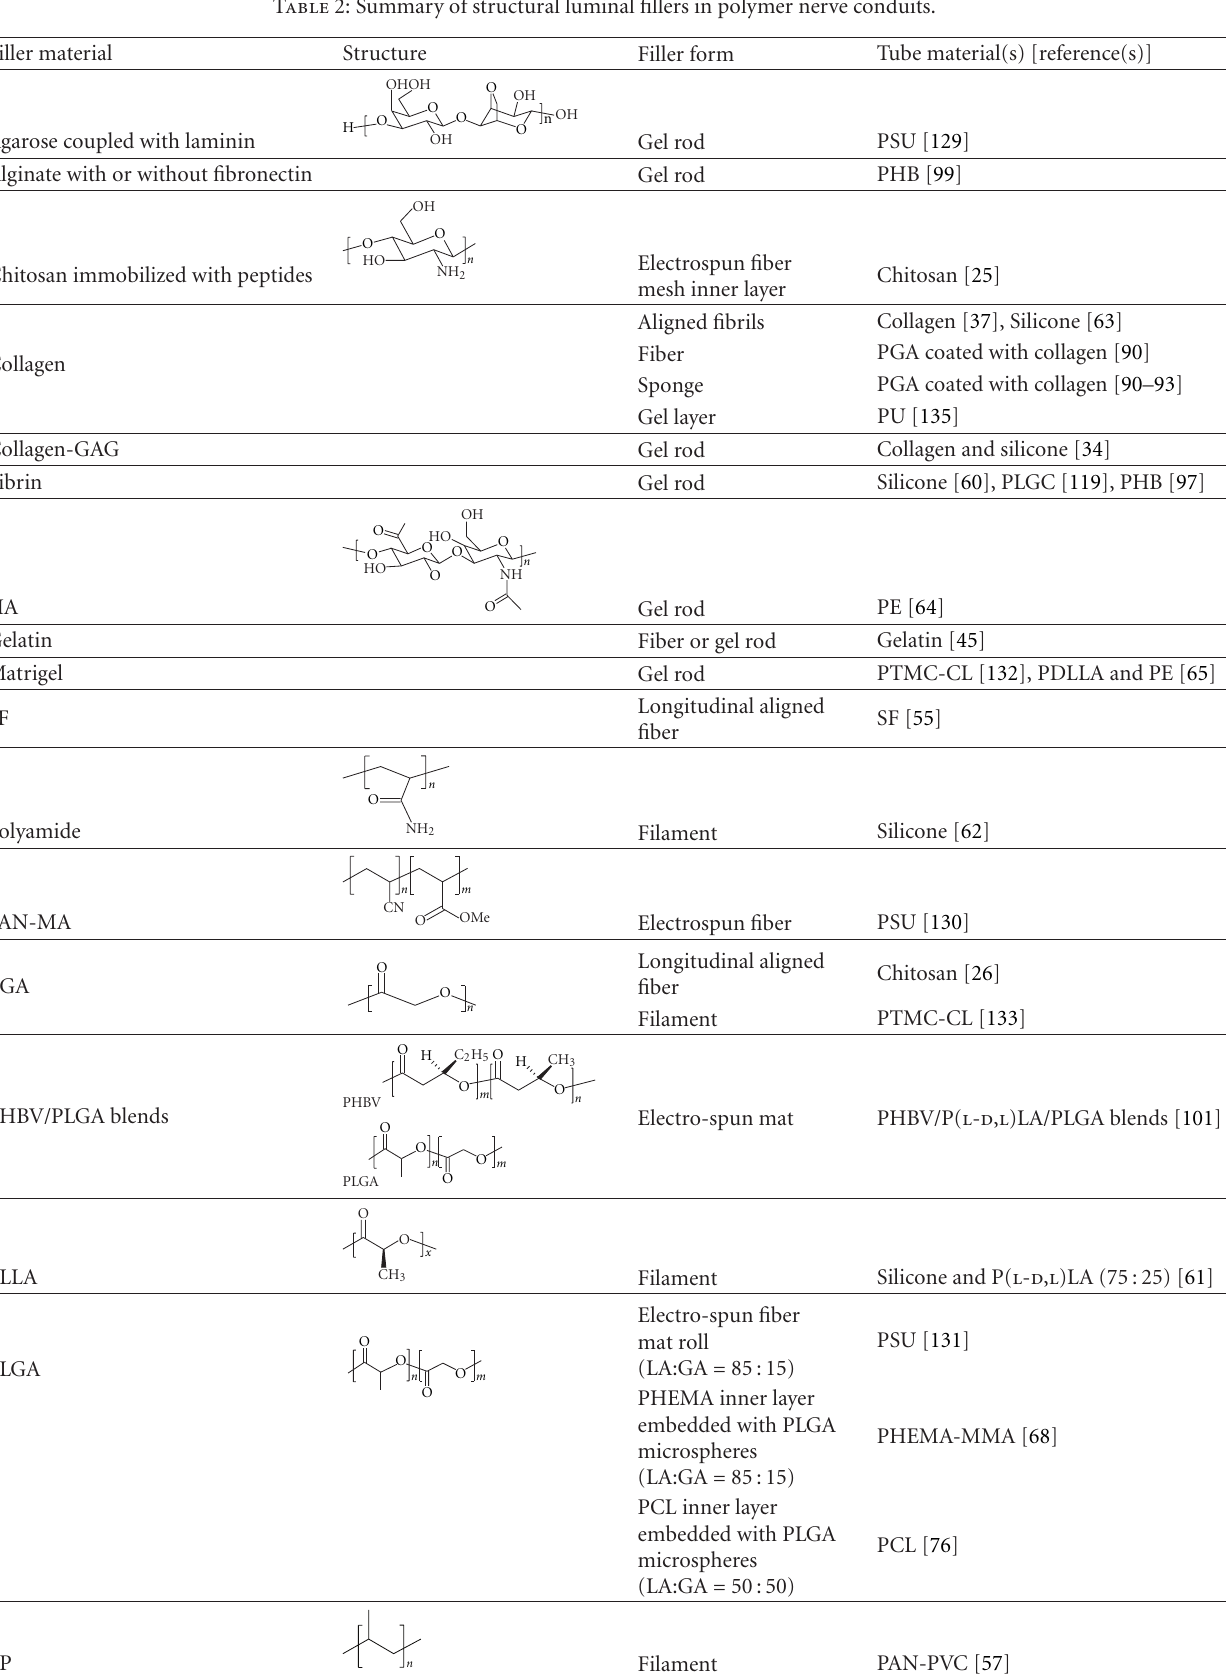
Table 2: Summary of structural luminal fillers in polymer nerve